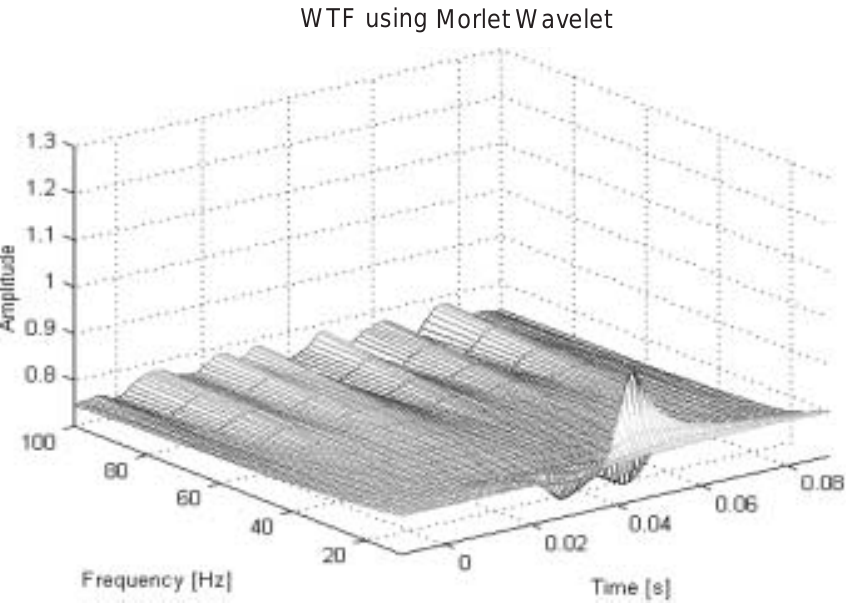
Fig. 14. WTF no clipping of the sinusoidal response of the damaged beam using sensors S1 and S2. (a) Helicopter rotor system (Picture Courtesy of Boeing Company). (b) Flexbeam